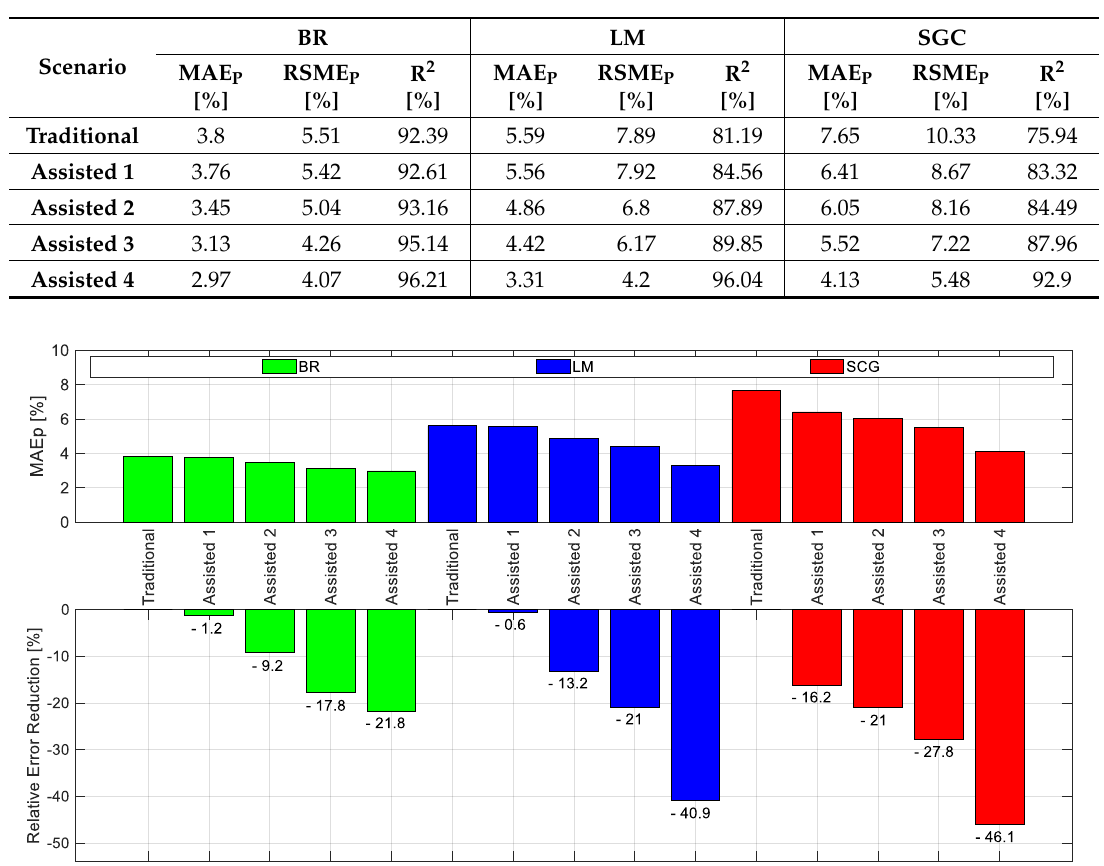
Figure 3. The effect of the assisted approach on the ANN prediction accuracy using the different learning algorithms. The MAE P values for the traditional and assisted approaches residual strength predictions ( top ), together with the error reduction of the assisted approach relative to the traditional approach ( bottom ). Averaged results for the 80 random combinations of the testing dataset.